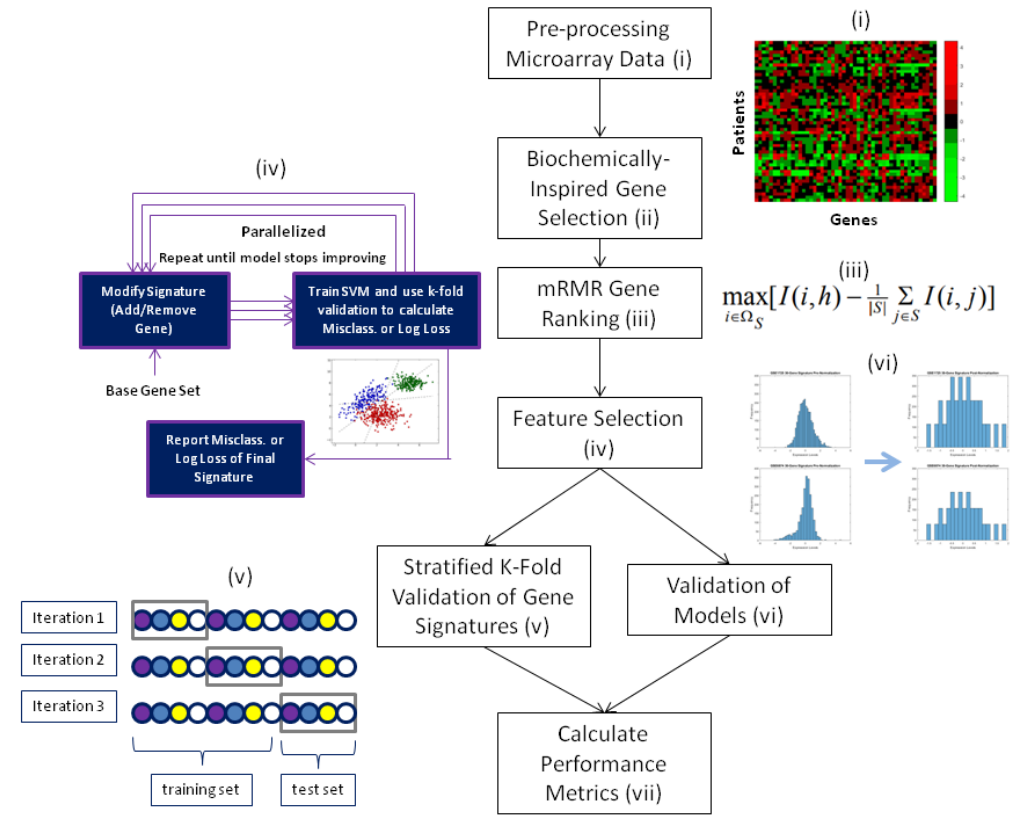
Figure 1. Flow chart of the biochemically inspired machine learning pipeline used to derive gene signatures. In panel (v), k-fold validation splits data into k sections, where each section acts as a test set in turn while the remaining sections act as a training set. Panel (v) depicts k-fold validation for k = 3. Coloured circles represent the samples in a dataset where different colours represent different radiation doses. In panel (vi), quantile normalization forces data into the same distribution. To demonstrate this, thirty random genes were chosen to form a signature. The histograms on the left represent the distributions of expression levels of these genes in the pre-normalized datasets GSE1725 and GSE6874[GPL4782]. The histograms on the right represent the distribution of expression levels of the same genes